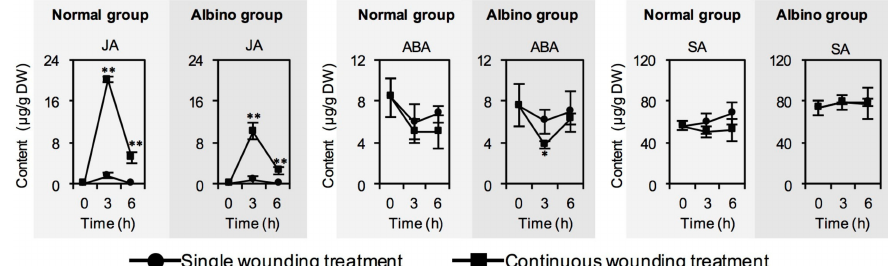
Figure 3. Changes in contents of phytohormones of normal tea leaves and albino tea leaves exposed to single wounding treatment and continuous wounding treatment, respectively. Data are expressed as mean ± SD ( n =3). * p ≤ 0.05; ** p ≤ 0.01, comparison between single wounding treatment and continuous wounding treatment at the same treatment time. JA, jasmonic acid; ABA, abscisic acid; SA, salicylic acid.